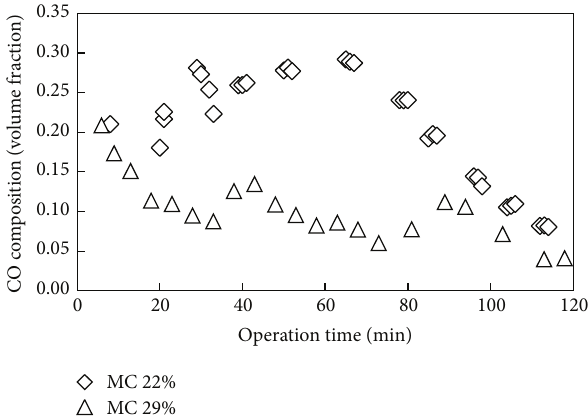
∗ Mean error between typical simulation results and experimental data based on sum square deviation method. ∗∗ LHV: low heating value.